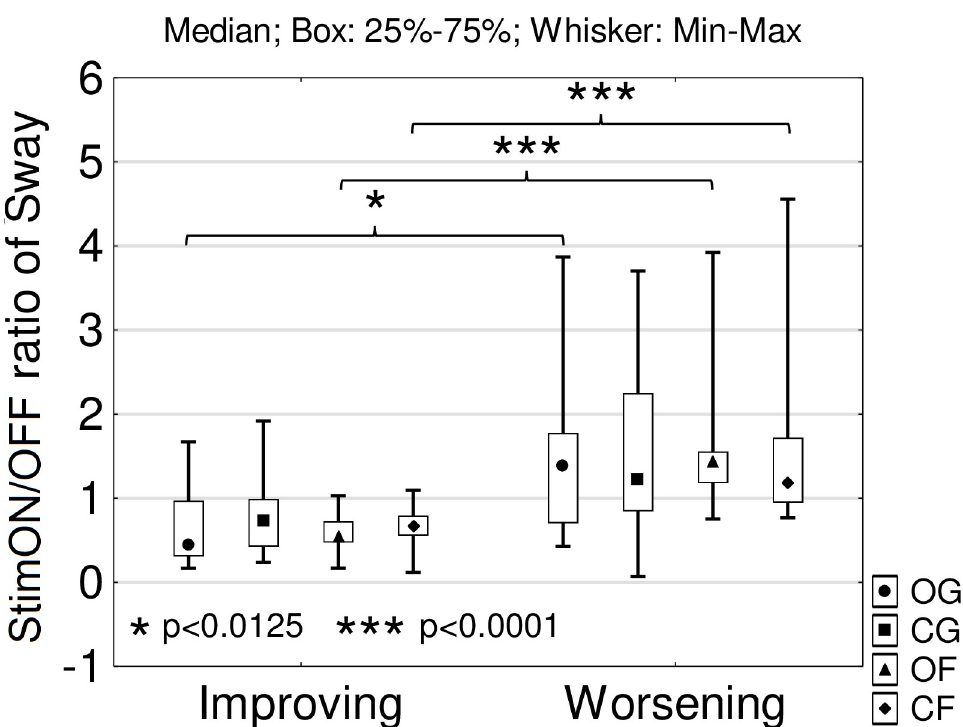
Fig 5. StimON/OFF sway ratio in the sensory conflict situations in the stimulation-induced improving and worsening subgroup. The subgroup with worsening balance had larger stimulation-induced instability in the tests except the eyes-closed, ground trials. The group with worsening balance especially could not compensate the dynamic changes of proprioceptive feedback processes. OG: Eyes-opened, ground; CG: Eyes-closed, ground; OF: Eyes-opened, foam; CF: Eyes-closed, foam.